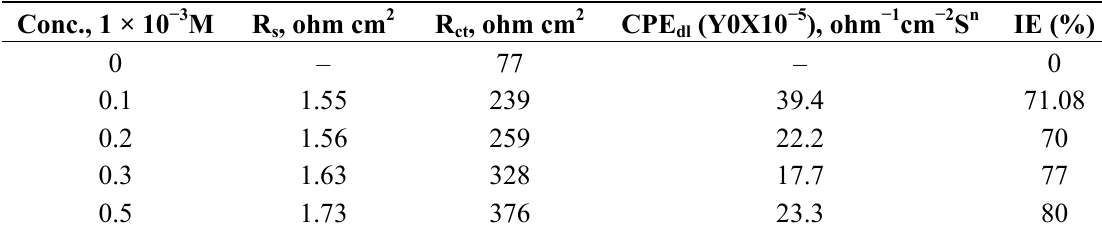
Table 1. Electrochemical impedance spectroscopy (EIS) parameters for mild steel in 1.0 M HCl with various concentrations of